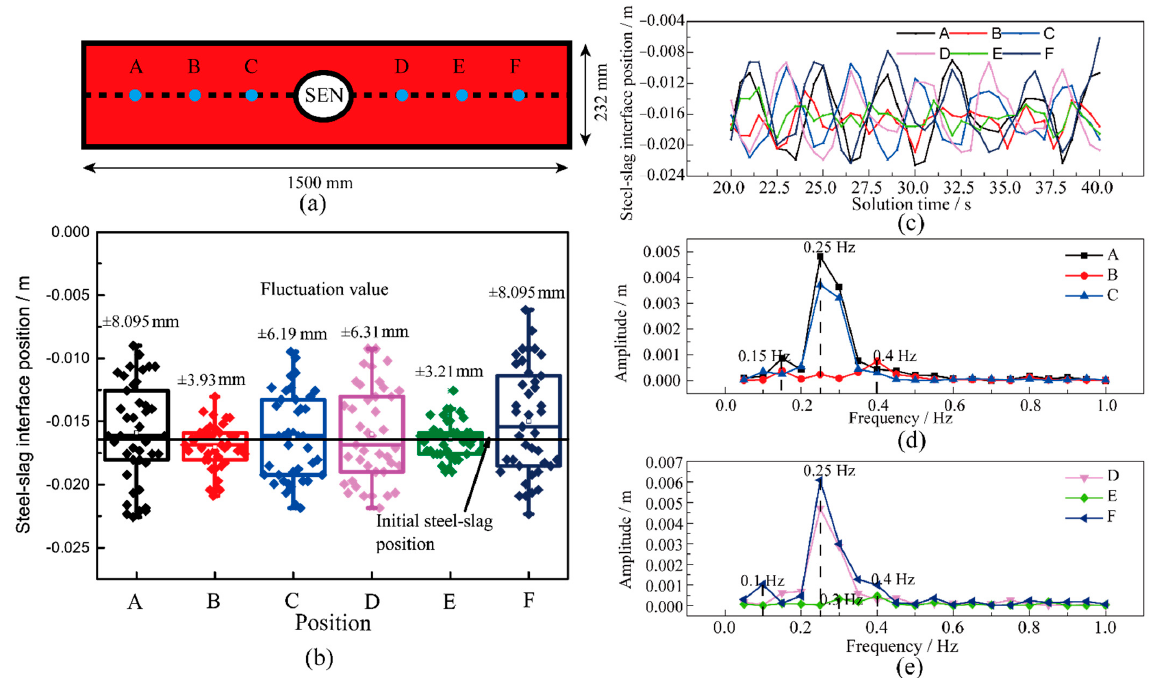
Figure 13. Comparison of steel–slag interface feature between ( a ) simulation result at 32 s, ( b ) simulation results at 30.5 s, and ( c , d ) experimental results for casting 260 tons Al-killed ultra-low carbon steel in different views.